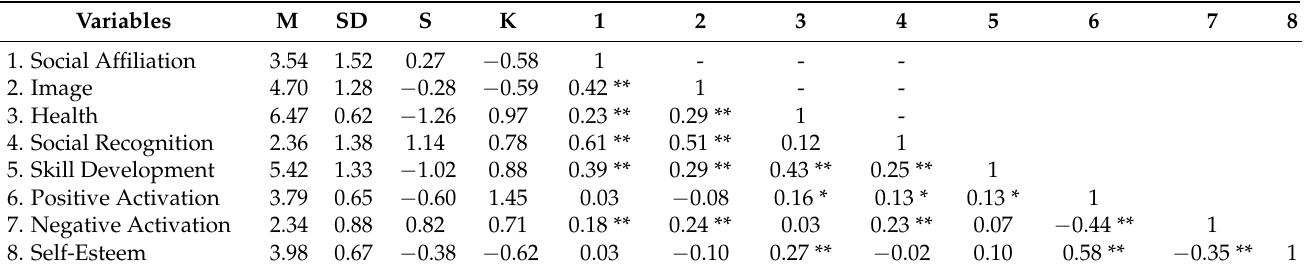
Table 1. Descriptive statistics and